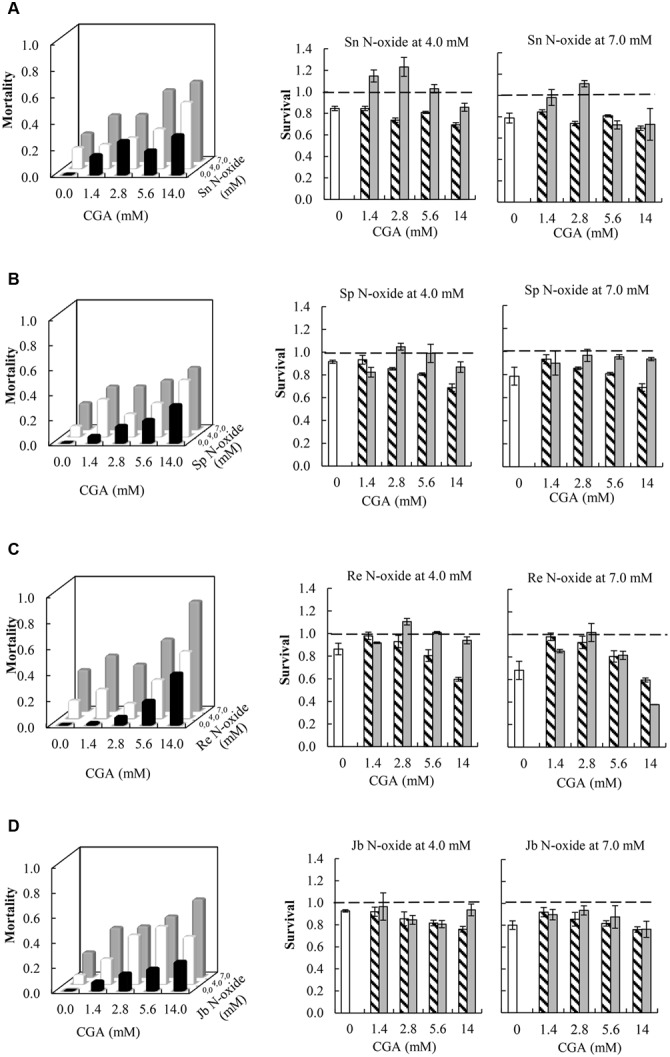
Left: Fraction mortality (1- fraction survival) of 2nd instar thrips larvae (F. occidentalis) caused by single metabolites and the combination of CGA with senecionine N-oxide (A), seneciphylline N-oxide (B), retrorsine N-oxide (C), and jacobine N-oxide (D). Right: Fraction survival (mean ± 95% confidence intervals) of thrips caused by PA N-oxides alone (white bars), CGA alone at four concentrations (hatched bars), and the interaction effect SX∗Y (Equation 4) between PA N-oxides and CGA (gray bars). In the left figures, the fraction mortality was plotted to increase the readability of the figure. In the right figures, the dashed line indicates a thrips survival fraction of one. A significant deviation from one indicates a synergistic (<1) or antagonistic effect (>1). Two-way ANOVAs were used to analyze whether the overall interaction effect SX∗Y deviated significantly from one (Table 3). Sn N-oxide, senecionine N-oxide; Sp N-oxide, seneciphylline; Re N-oxide, retrorsine N-oxide; Jb N-oxide, jacobine N-oxide.